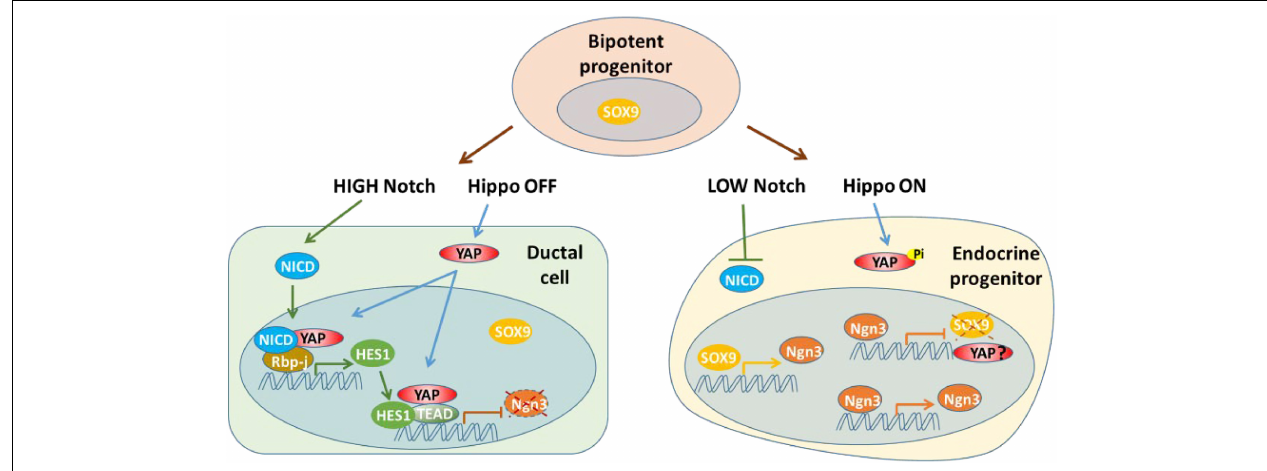
FIGURE 3 | YAP acts as both a transcription activator and repressor with Notch signaling pathway during endocrine development. YAP may be suppressed at transcription level in endocrine progenitor